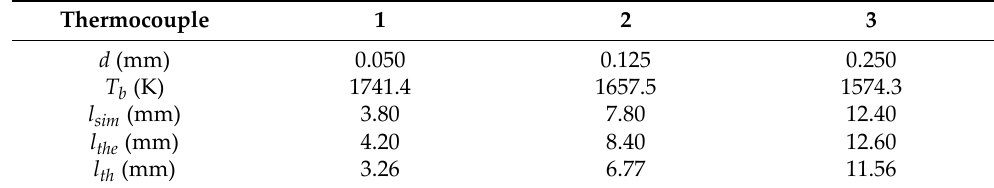
Table 1. Effective length of three thermocouples.